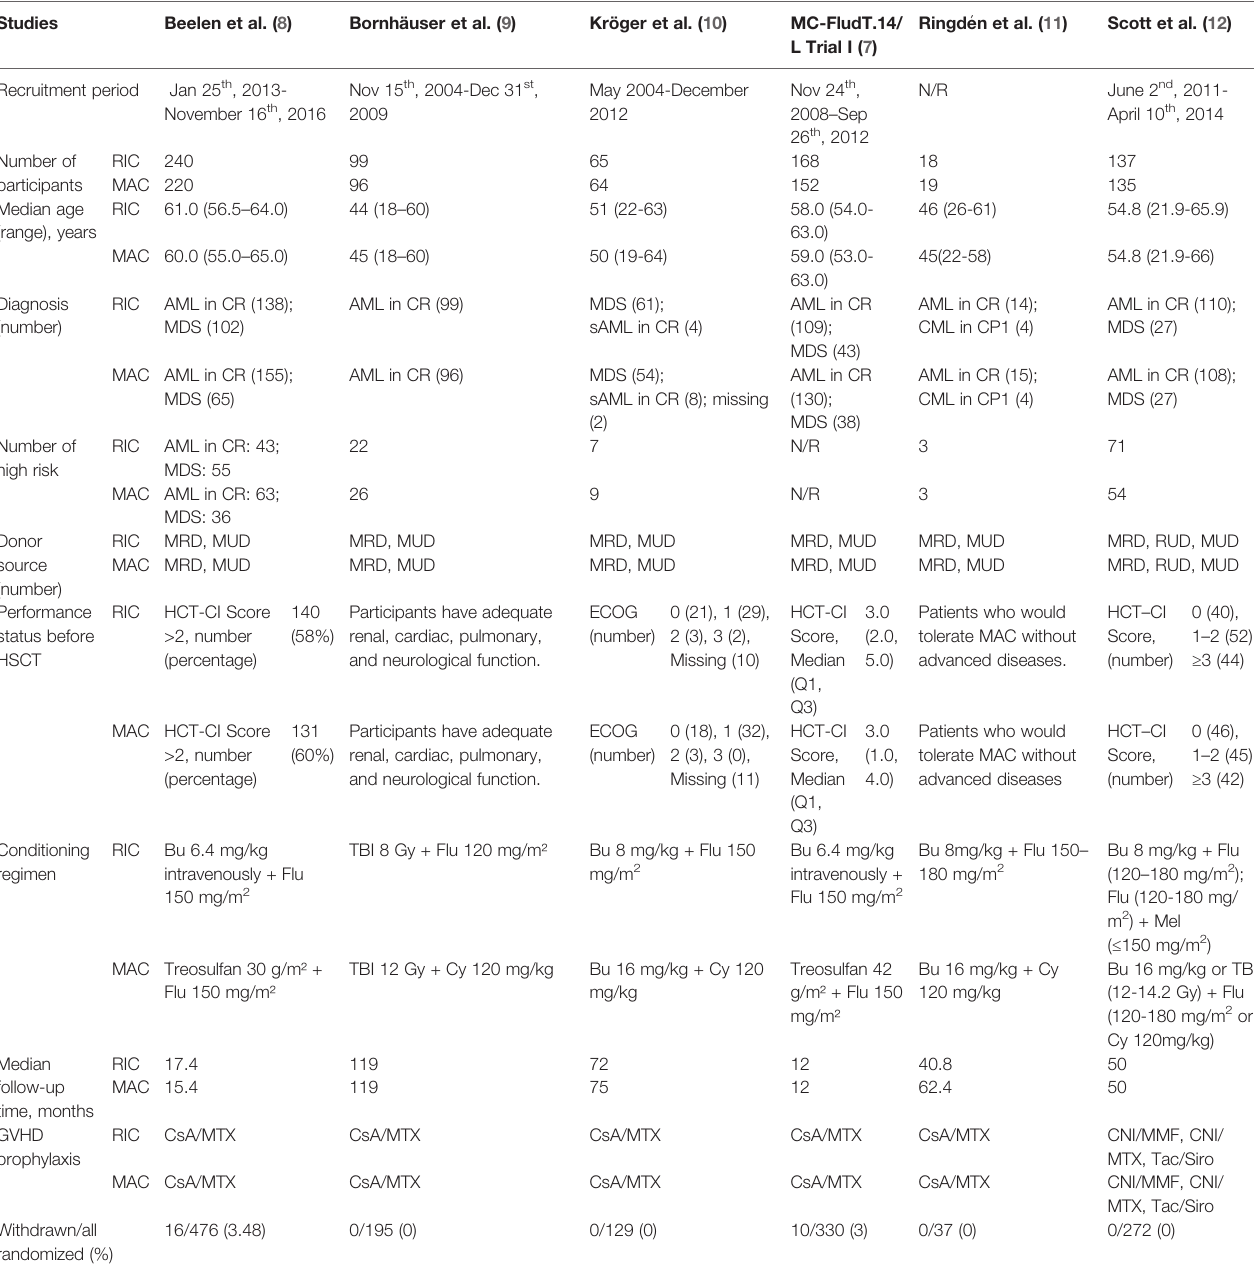
TABLE 1 | Demographic characteristics of included